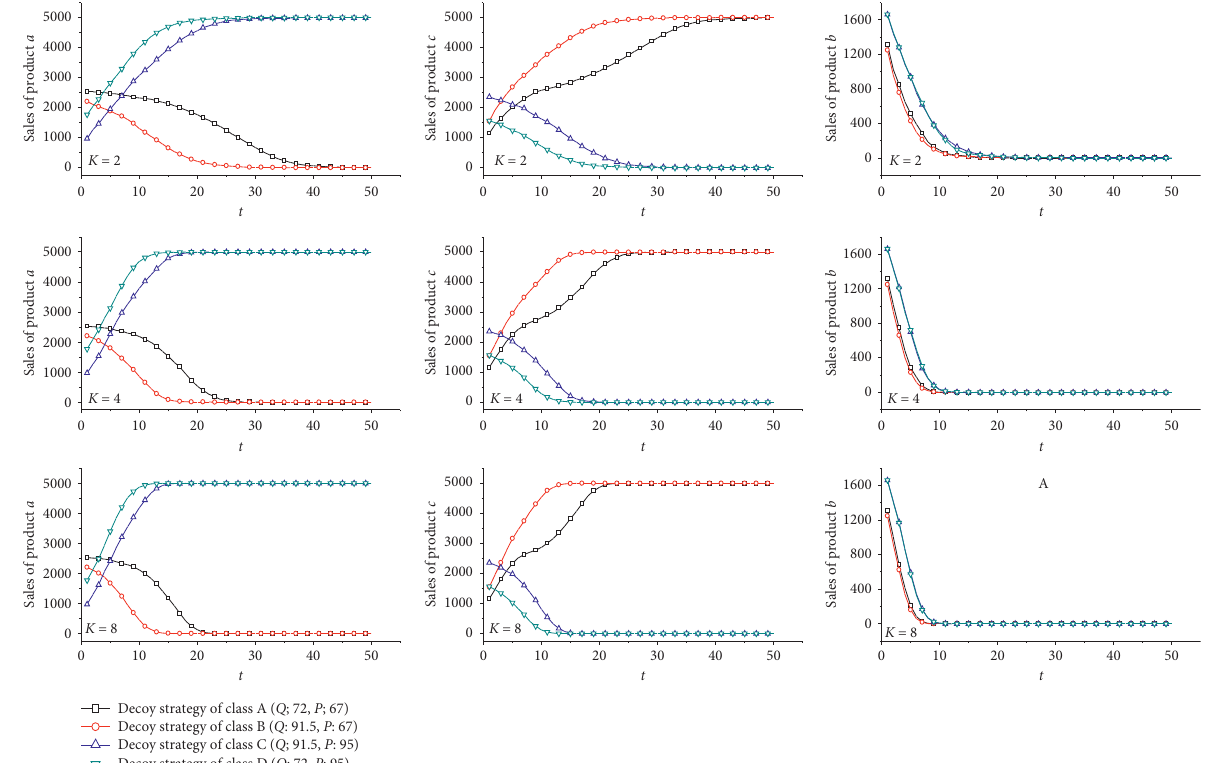
Figure 5: Evolution trends for sales of products a , c , and b under different true decoy strategies in scenarios with different neighbor node values.